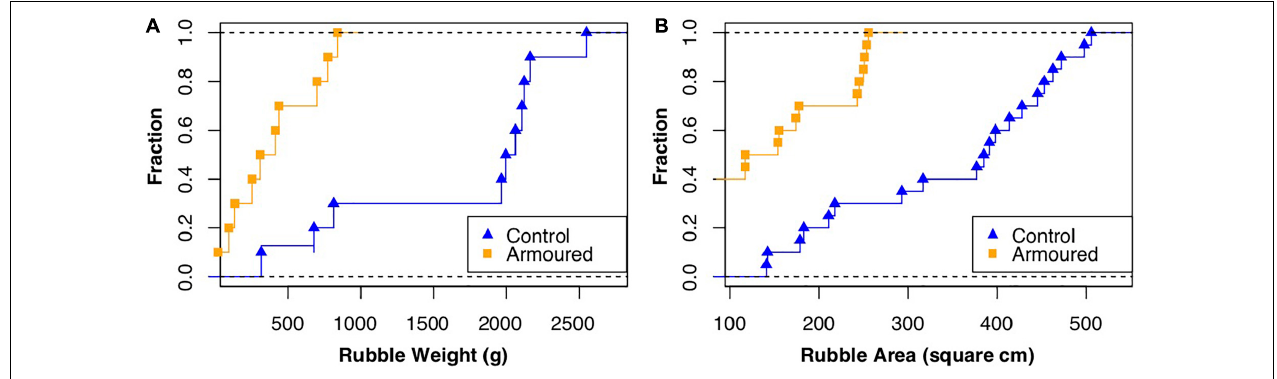
FIGURE 3 | Cumulative curves of rubble (A) weight and (B) surface area for rubble sampled at breakwater and control site.